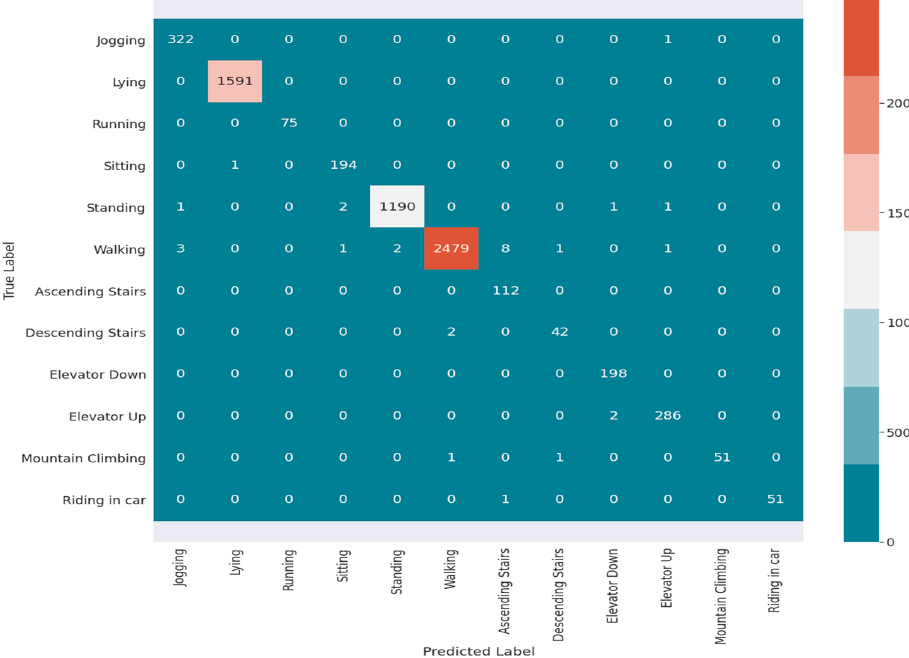
Figure 12. Confusion matrix for the contextual model.